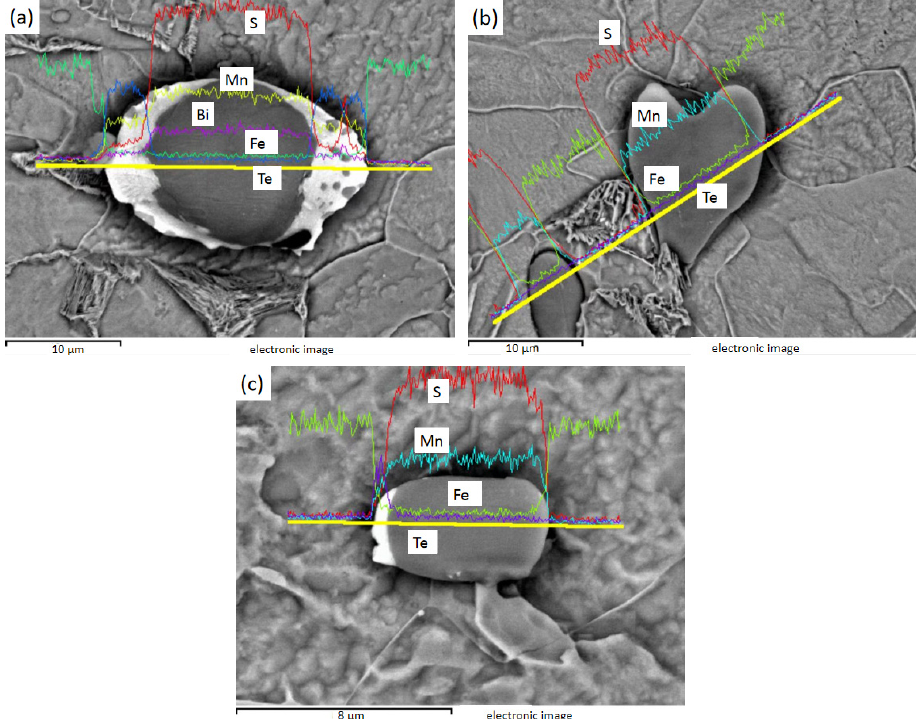
Figure 10. 3# MnS inclusions of heart shape and with Te on either side or one side: ( a ) fusiform MnS containing Te on both sides and Bi in the middle; ( b ) heart-shaped MnS; ( c ) MnS with Te on one side.